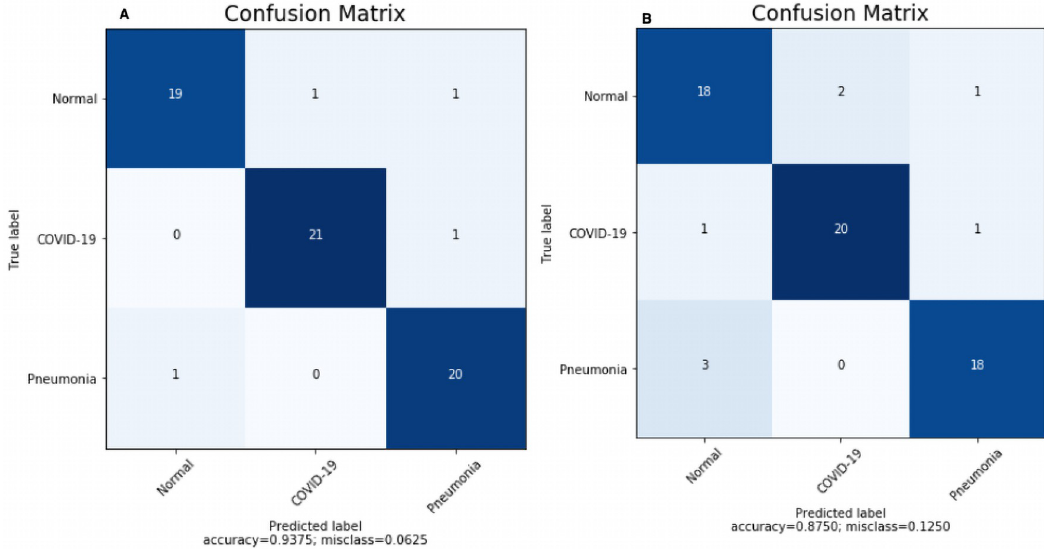
Fig 9. Confusion matrices for scenario II obtained by (A) build CNN and (B) VGG16.